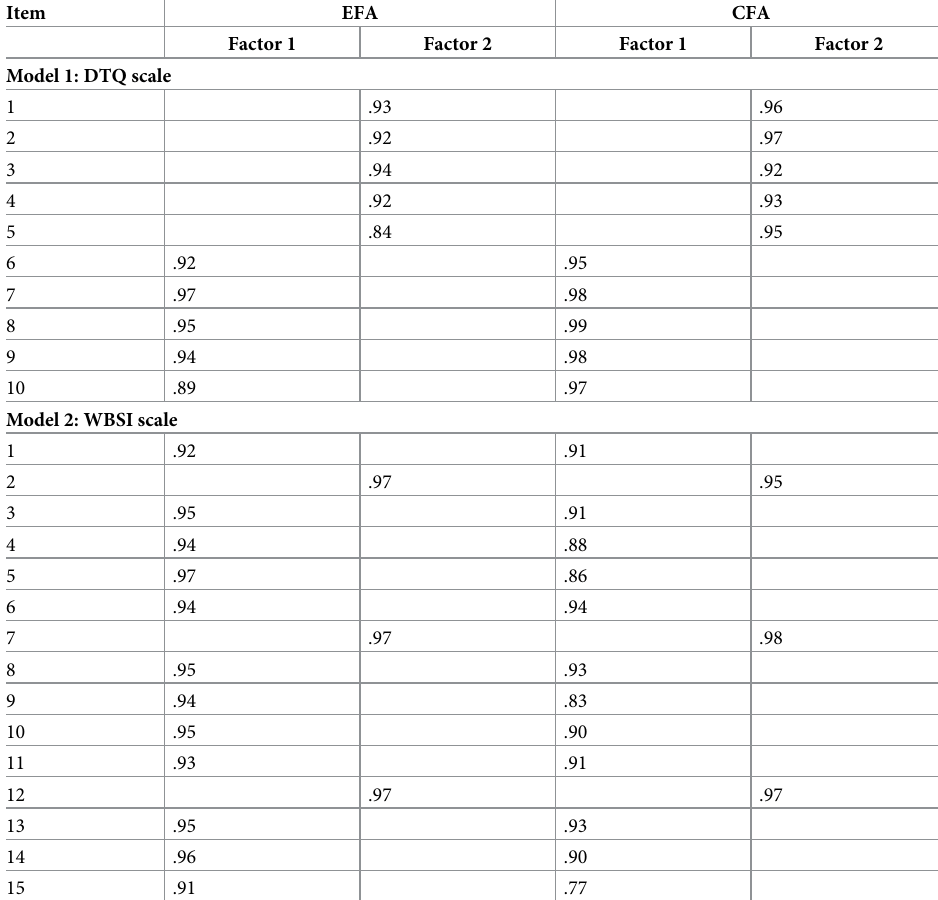
Table 2. Items of the DTQ and WBSI in English and factor loadings derived from the Exploratory Factor Analyses (EFA) with women and men in the first split-half subsample, and standardized estimates of factor loadings from the Confirmatory Factor Analysis (CFA) in the second split-half subsample.